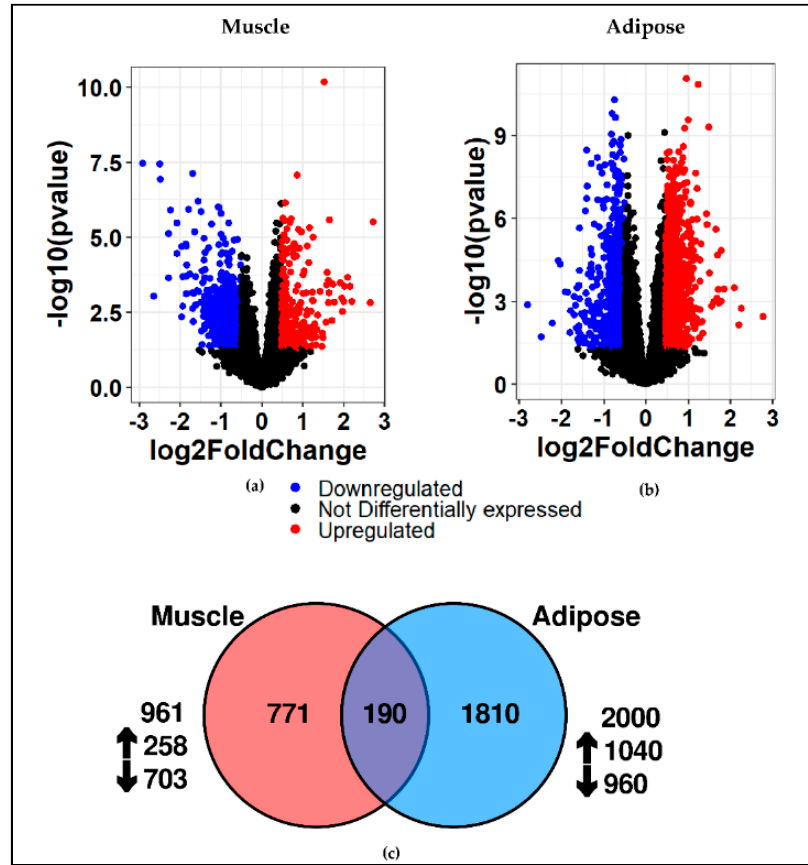
Figure 3. Identification of differentially expressed genes in muscle and adipose. Volcano plot showing the differentially expressed genes for muscle ( a , b ) adipose at 1.4 fold change and p -value of 0.05. Red indicates upregulation and blue indicates downregulation; ( c ) the common differentially expressed genes between muscle and adipose is ~7%.